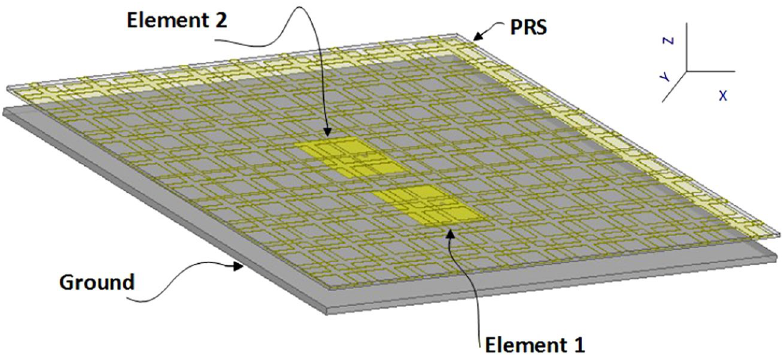
Figure 4. Proposed MIMO antenna design with PRS placed at λ /10 height.